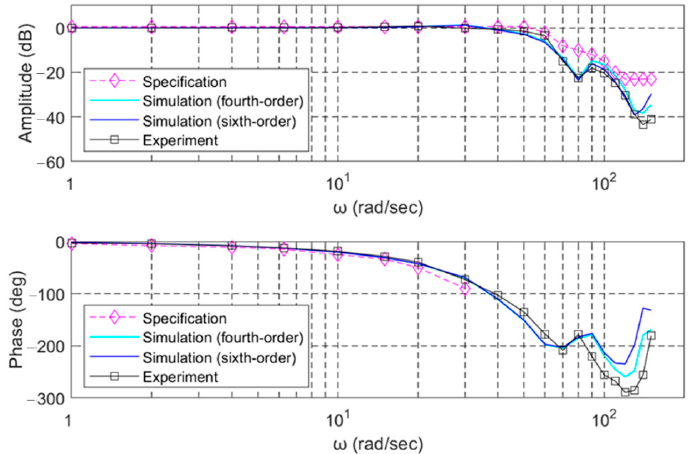
Figure 18. The final output X L 1 dynamics of the electro-hydraulic actuation system with the com- bined control algorithm. Table 6. The compensated load dynamic response at the specified frequencies with the combined control algorithm.